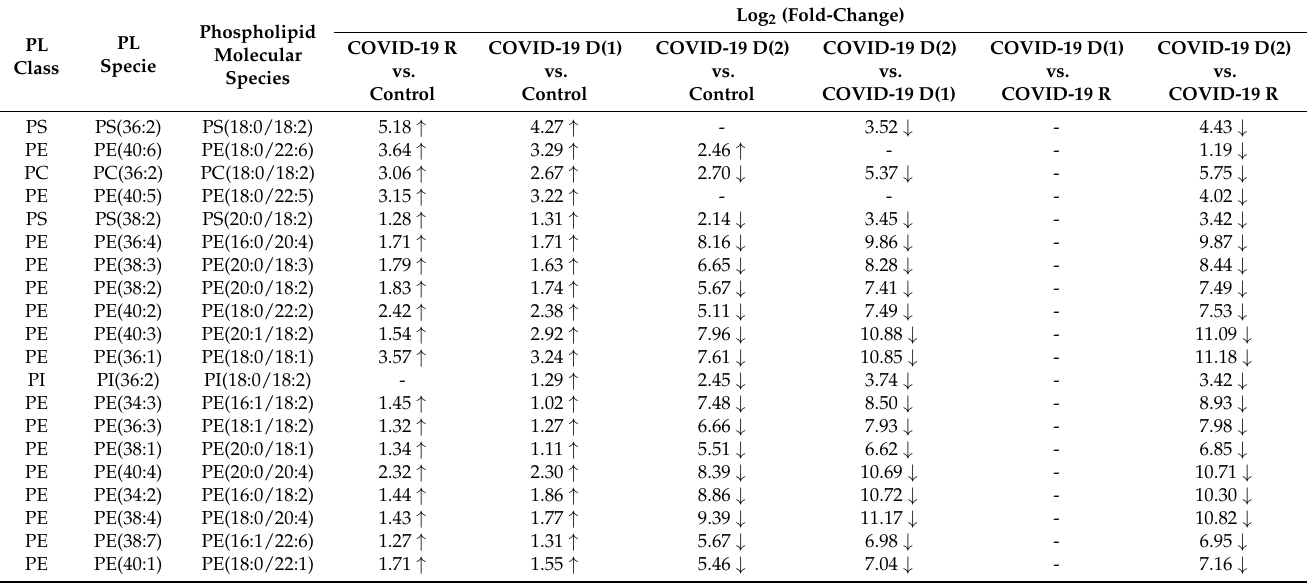
One-way ANOVA) phospholipid species from PE, PS and PI class in the plasma of healthy subjects ( n = 20) [Control] , first subgroup of deceased COVID-19 patients ( n = 15) [COVID-19 D(1)] , second subgroup of deceased COVID patients ( n = 5) [COVID-19 D(2)] and recovered COVID-19 patients ( n = 20) [COVID-19 R]